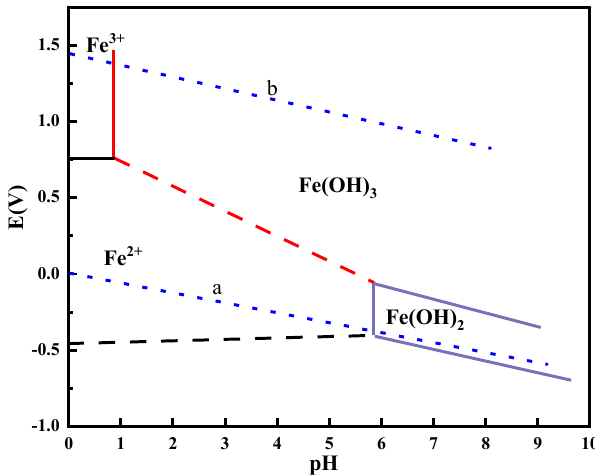
Figure 5. Fe ‐ H 2 O system E ‐ pH. Figure 5. Fe-H 2 O system